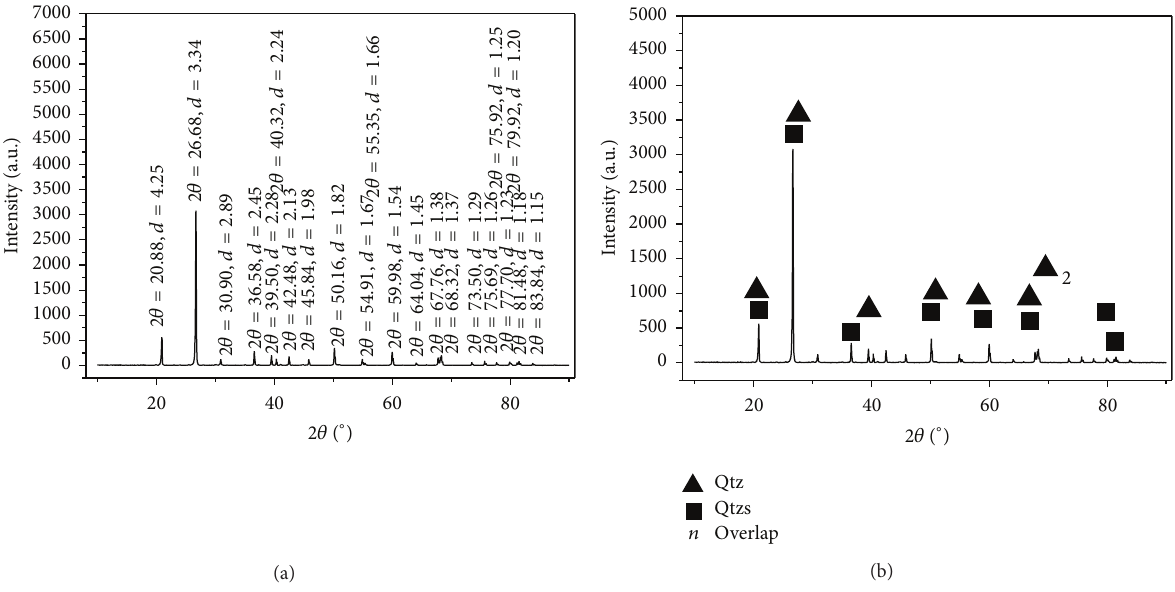
Figure 19: XRD diagram for siliceous rock of the Bafangshan-Erlihe